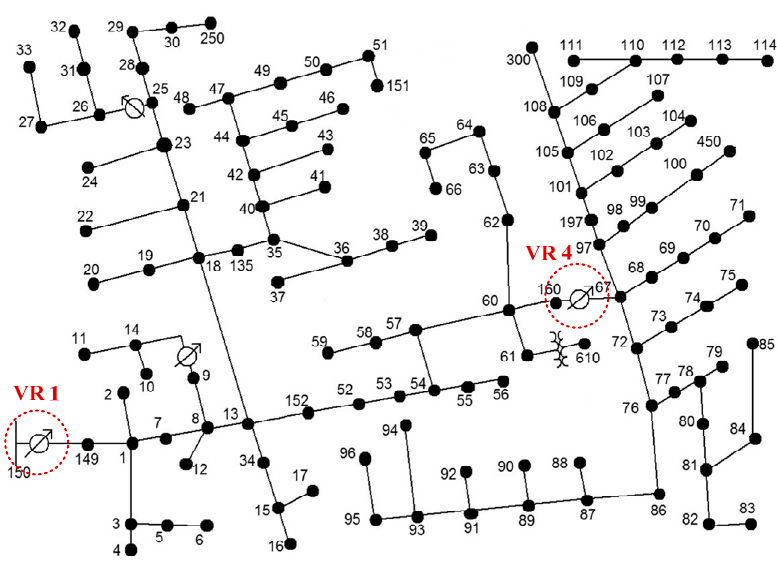
Figure 8. IEEE 123 ‐ node test feeder. Figure 8. IEEE 123-node test feeder.